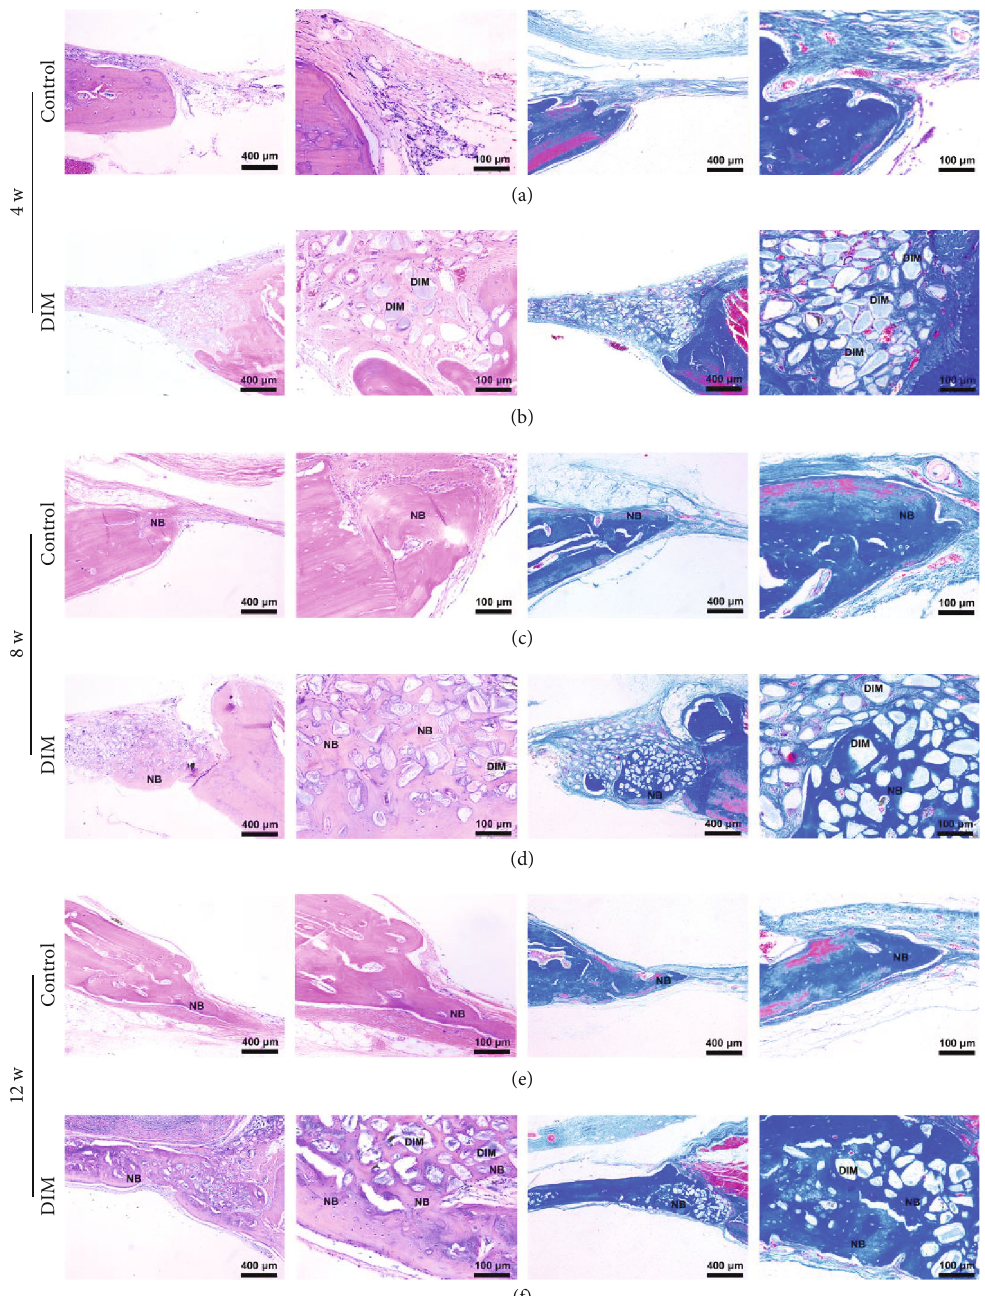
Figure 6: H&E and Masson ’ s trichrome staining analysis of bone defects treated with DIM at 4, 8, and 12 weeks after surgery. (a, b) Coronal images of bone defects in DIM implantation and the control group after 4 weeks. (c, d) Coronal images of bone defects in the DIM implantation group and the control group after 8 weeks. (e, f) Coronal images of bone defects in the DIM implantation group and the control group after 12 weeks. DIM represents the residual material embedded in new bone. NB represents the newly formed